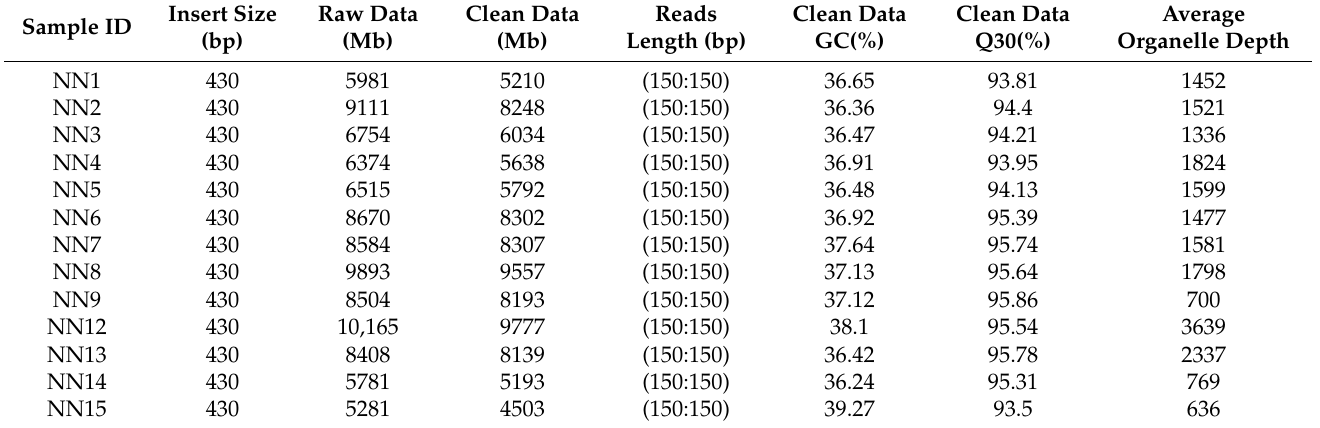
Table 2. Summary of sequencing data for 13 cp genomes.